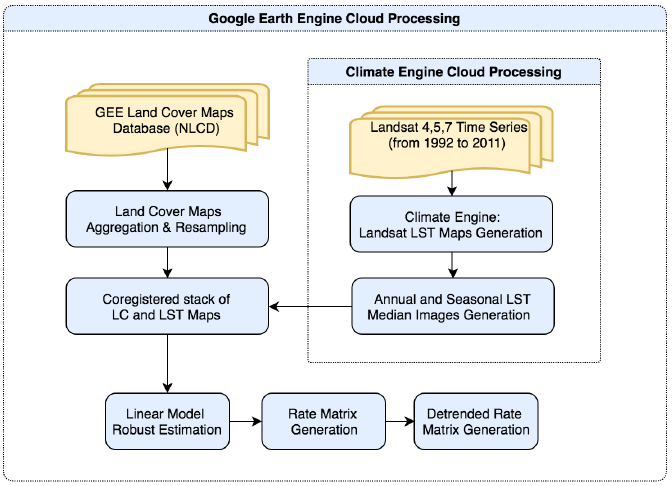
Figure 1. The workflow of the